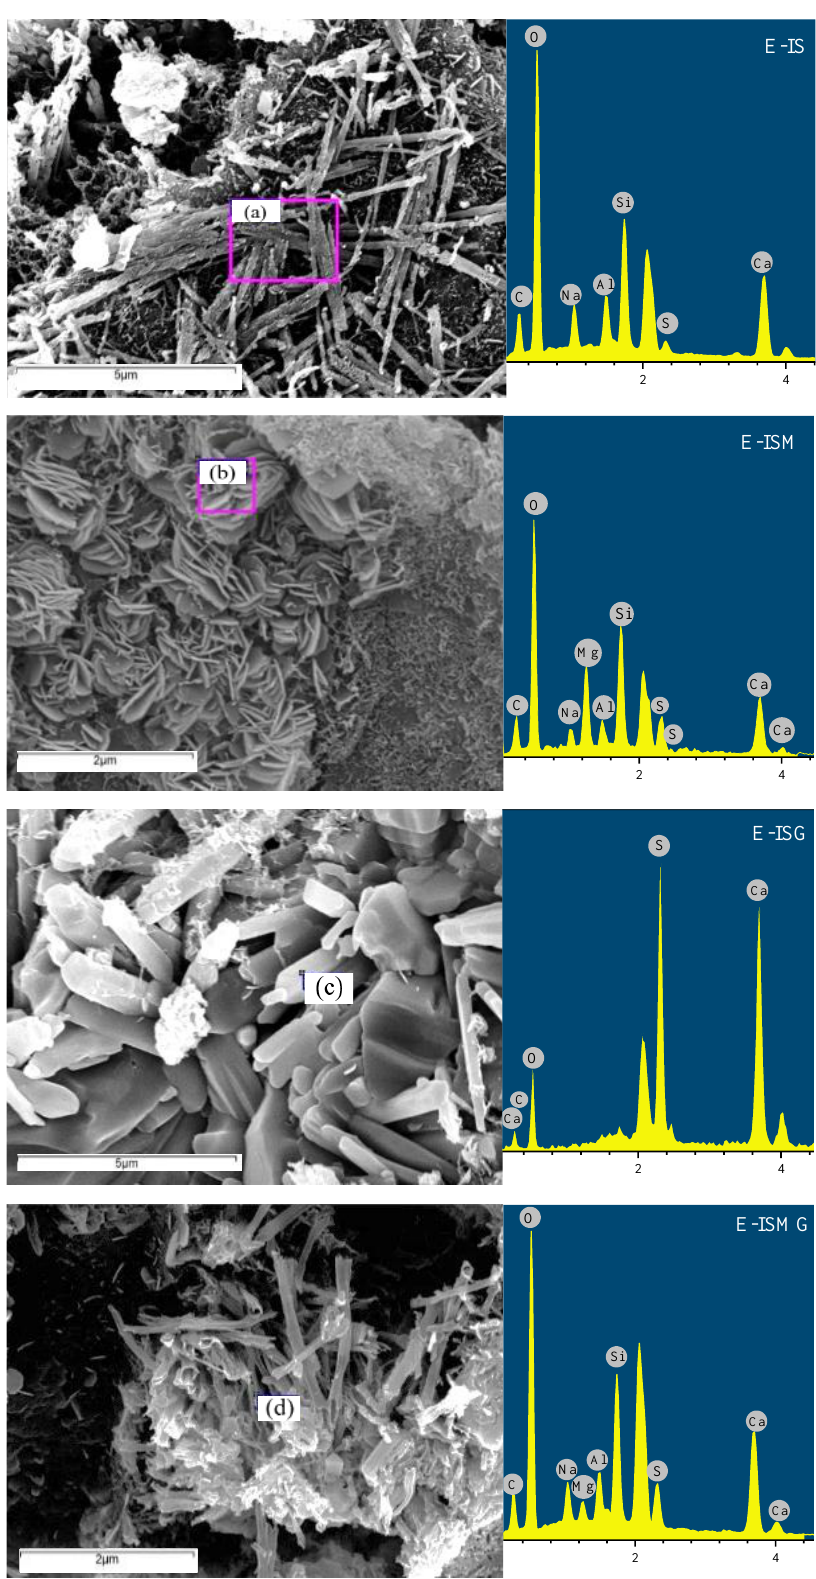
Figure 8. SEM observations and EDS results for specimens immersed in sulfate solution at 28 days: ( a ) E-IS, ( b ) E-ISM, ( c ) E-ISG, and ( d ) E-ISMG. Note: purple box is the selected area to do EDS analysis.